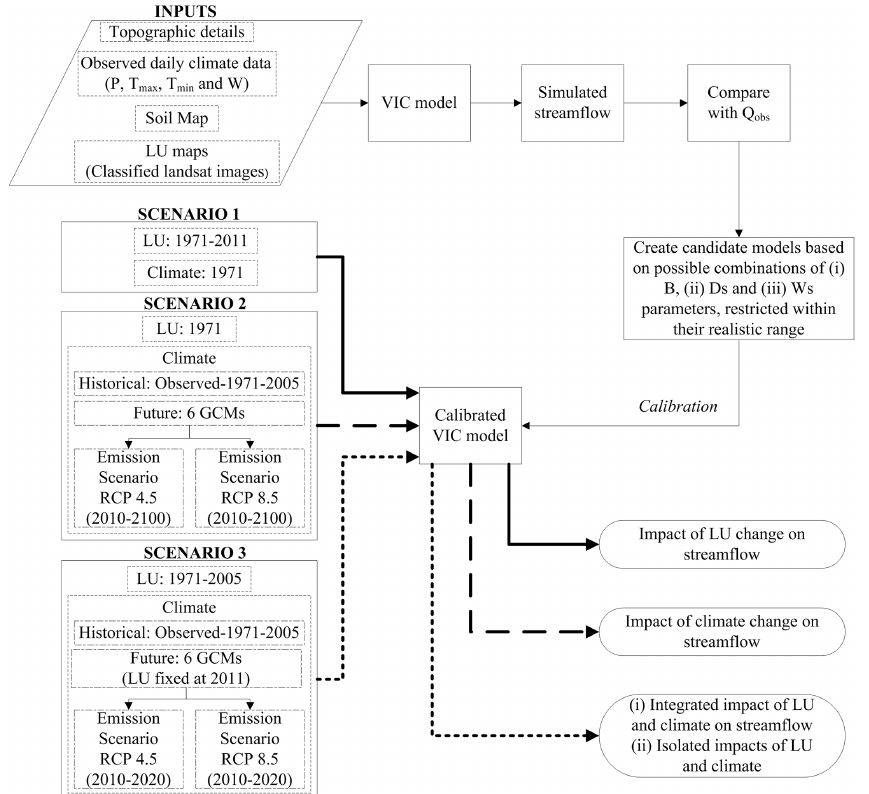
Figure 6. Overview of the